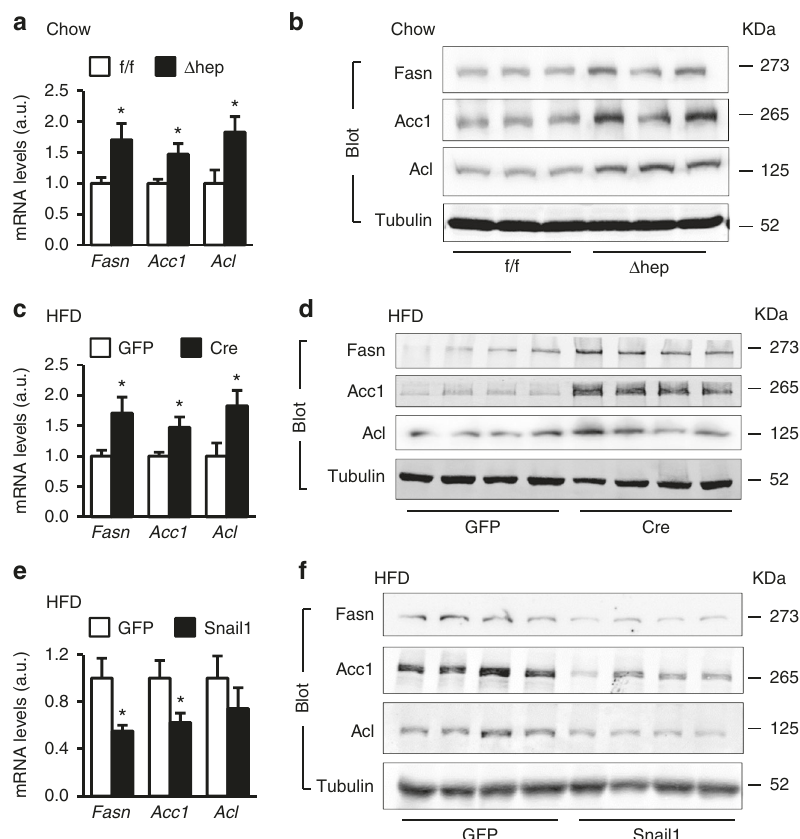
Fig. 5 Snail1 directly suppresses liver lipogenic programs in vivo. a , b Snail1 Δ hep ( n = 6) and Snail1 fl ox/ fl ox ( n = 6) males fed a normal chow diet for 18 weeks. c , d Snail1 fl ox/ fl ox male mice (8 – 9 weeks) were fed a HFD for 6 weeks and transduced with AAV-TBG-GFP ( n = 6) or AAV-TBG-Cre ( n = 6) vectors. Livers were harvested 4 weeks after AAV transduction. e , f C57BL/6 male mice (8 – 9 weeks) were fed a HFD for 7 weeks and transduced with Snail1 ( n = 5) or GFP ( n = 5) adenoviral vectors. e Liver Fasn , Acc1 , and Acl expression was assessed by qPCR (normalized to 36B4 expression). f Liver extracts were immunoblotted with the indicated antibodies. Fasn, Acc1, and Acl levels were quanti fi ed and normalized to α -tubulin levels. Data are presented as mean ± SEM. * p < 0.05, two-tailed unpaired Student ’ s t